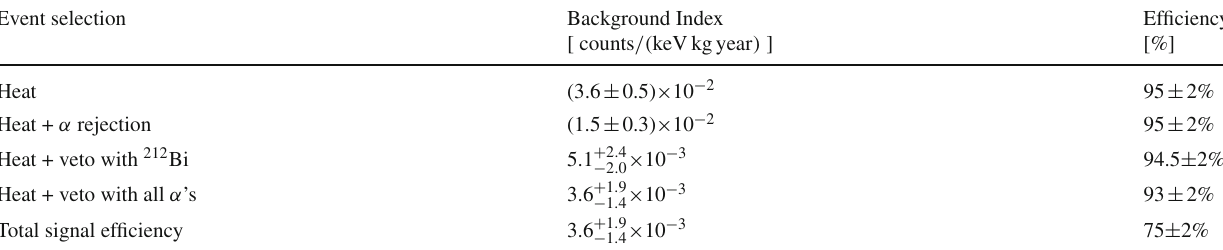
Table 1 Summary of the background index (counts/keV/kg/y) and signal efficiency averaged on the DataSets exposure, measured in the region 2800–3200 keV with a ZnSe exposure of 3.44kg · y (1 . 34 × 10 25 emitters · y). Uncertainties are reported at 68% C.L.. First row: events thatpassthecutsontheheatdescribedinSect.6.Secondrow:theevents arefurtherselectedrequiringthattheshapeparameterofthelightiscon- sistent with interactions of electrons ( α rejection) as described in Sect.